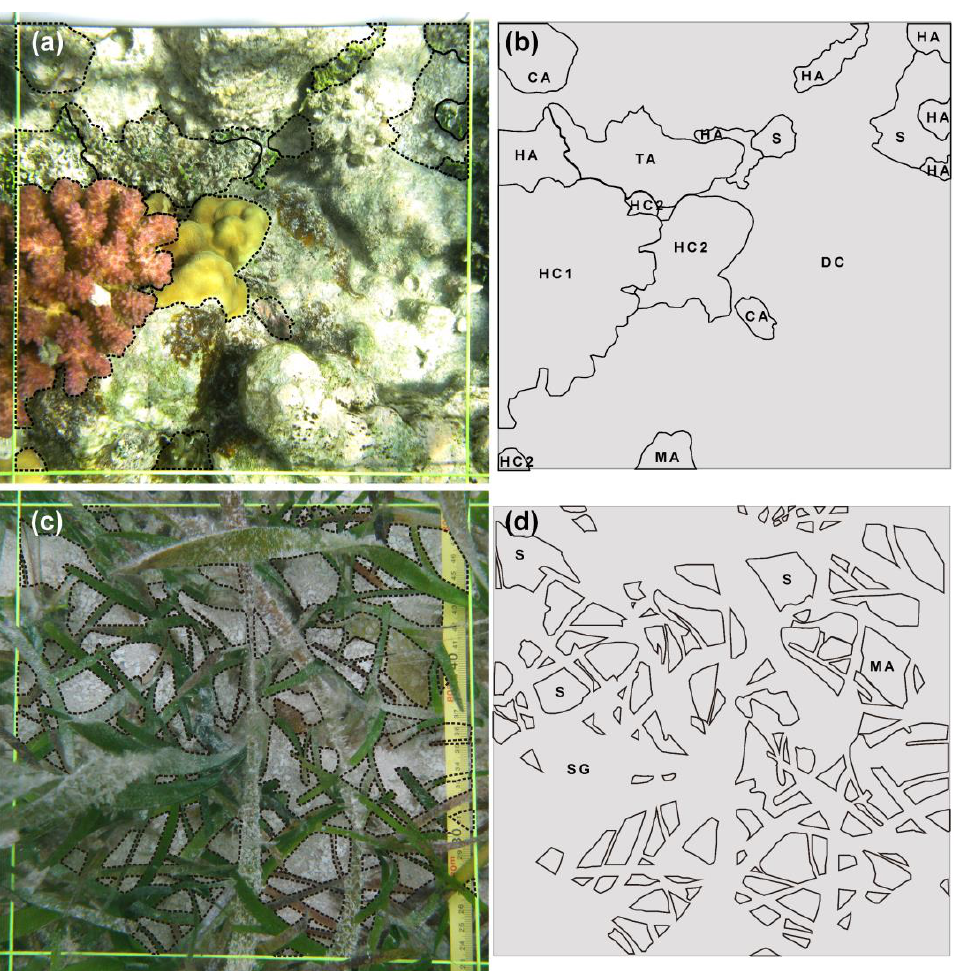
Figure 3. Process of digital image analysis. ( a ) In situ image of photo-quadrat in coral reef habitat ( b ) Coral reef habitat type resulting from analysis of in situ image. DC: dead coral, HC1: hard coral,